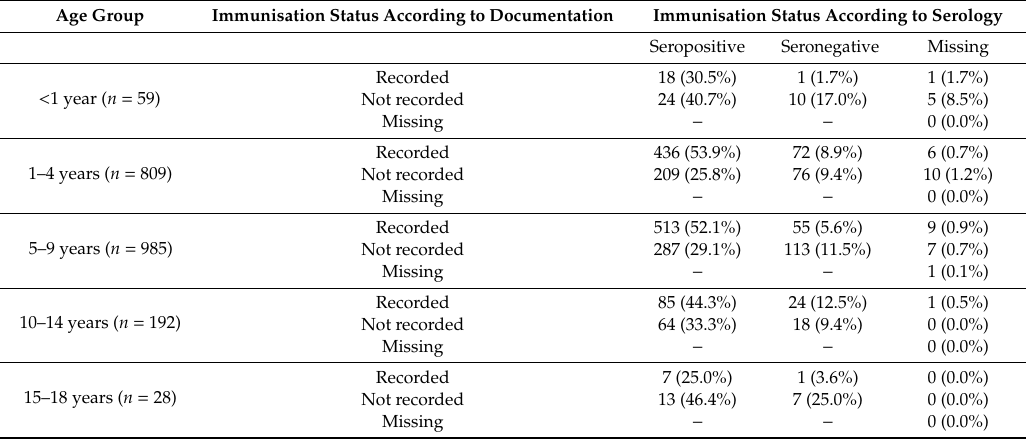
Table A6. Comparison between immunisation status of IAC reported in the documentation and serology for tetanus, by age